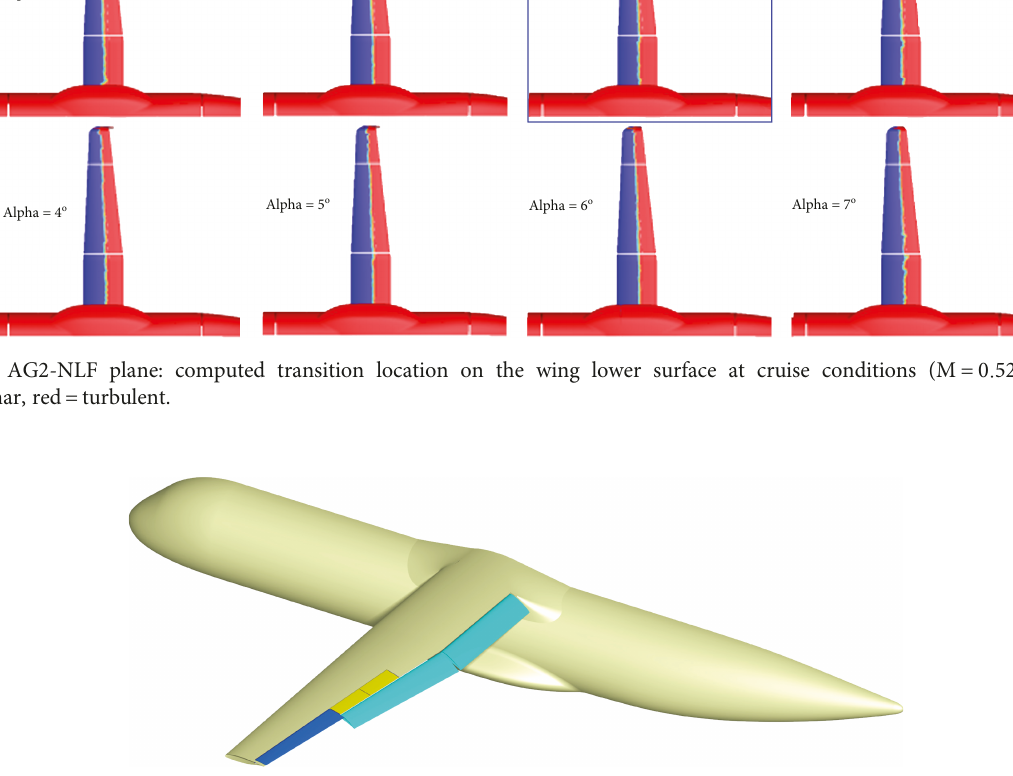
Figure 12: General layout of the AG2-NLF wing for fl ap arrangements.